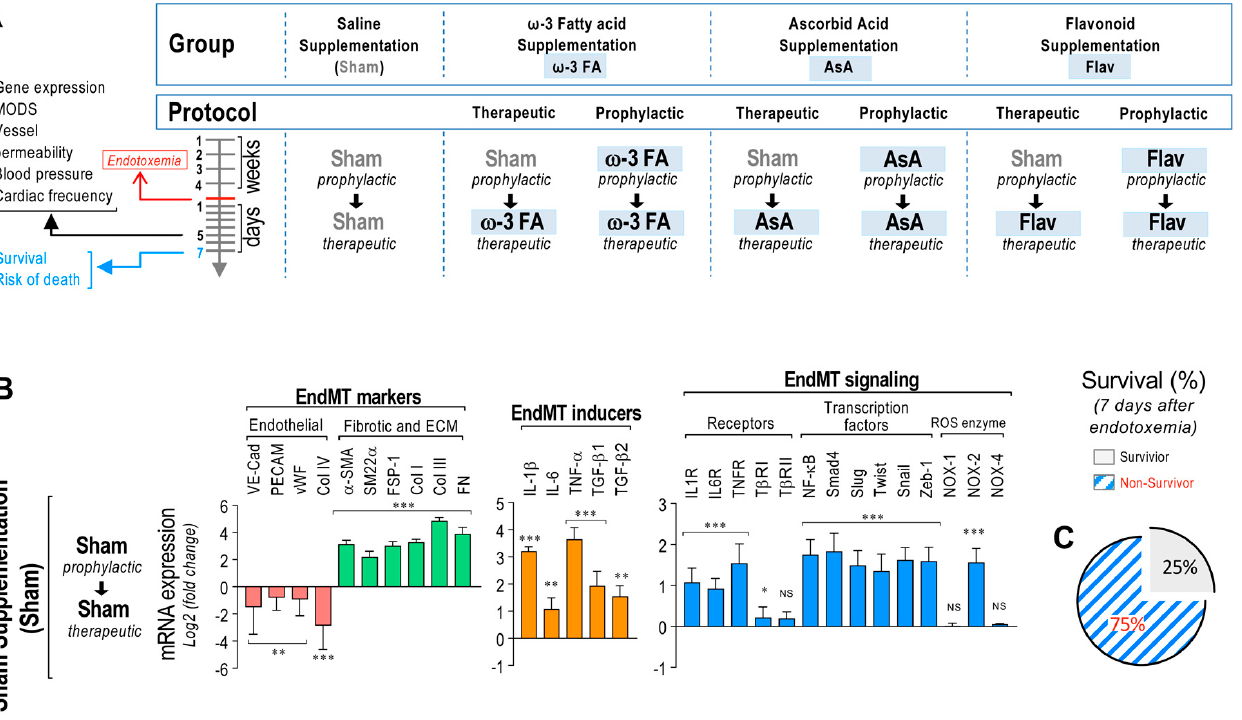
Figure 1. EndMT gene expression in endotoxemic rats. ( A ) Scheme of the strategy of saline– and endotoxemia–treated rats subjected to dietary supplementation by means of a prophylactic (4 weeks before and during the 7 days of endotoxemia) and a therapeutic (only during the 7 days of endotox- emia) protocol. Sham supplementation (Sham), ω –3 fatty acid supplementation ( ω –3 FA) , ascorbic acid supplementation (AsA), and flavonoid supplementation (Flav). ( B ) The mRNA expression of EndMT markers (endothelial markers (red bars) and fibrotic and ECM markers (green bars)), EndMT inducers (orange bars), and EndMT signaling (blue bars) was detected in rats subjected to endotoxemia. ( C ) Survival percentage was determined 7 days after endotoxemia induction in rats subjected to endotoxemia. Statistical differences were assessed by a one-way analysis of variance (ANOVA) (Kruskal–Wallis) followed by Dunn’s post hoc test. * p < 0.05, ** p < 0.01, *** p < 0.001 compared with the saline-treated condition. NS: non-significant. Determination of mRNA expression was normalized relative to 28S mRNA and is expressed relative to sham-supplemented condition. Values are expressed as the mean ± SD. ( N =